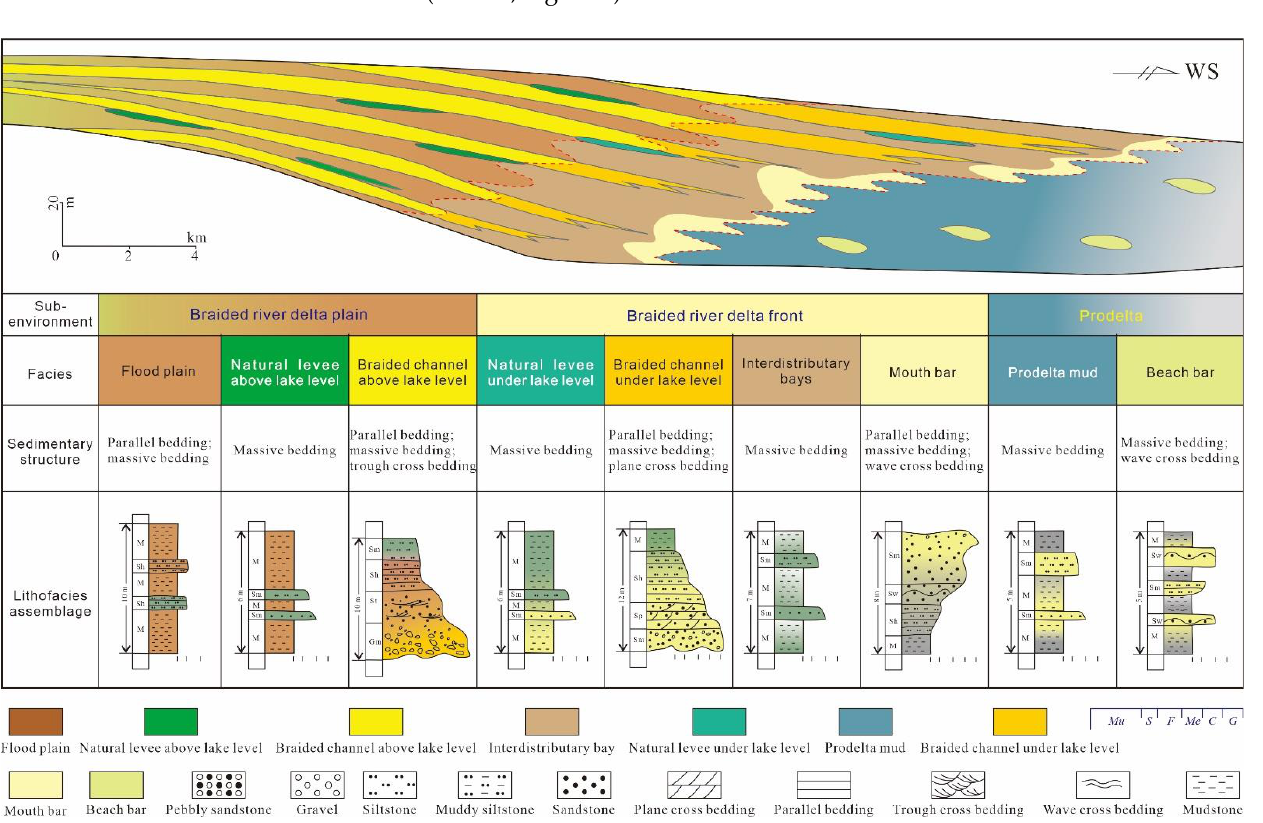
Figure 8. Diagram of the main types of sedimentary facies and sedimentary characteristics of the Jiucaiyuan Formation in the Beisantai Uplift. Mu: mudstone; S: siltstone; F: fine-grained sandstone; Me: medium-grained sandstone; C: coarse-grained sandstone; and G: gravel.